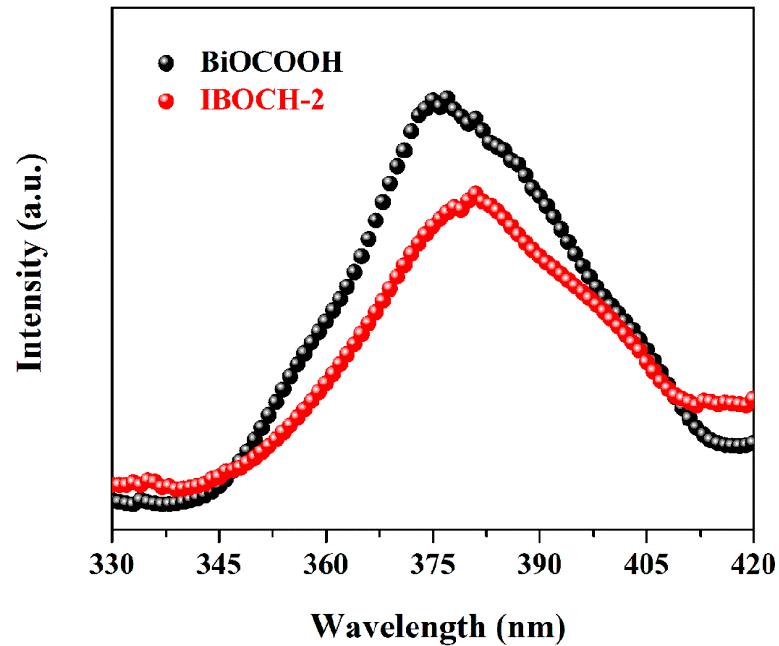
Figure 11. Photoluminescence (PL) spectra of BiOCOOH and the IBOCH-2 heterojunction.